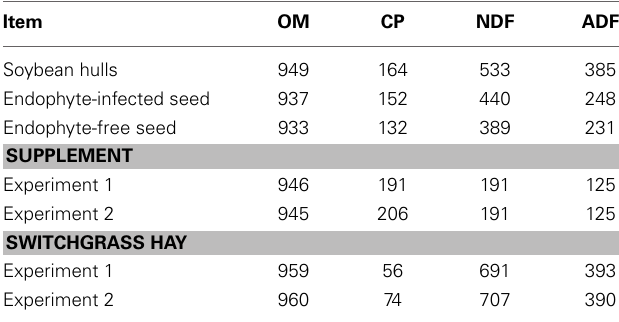
Table 1 | Organic matter (OM), crude protein (CP), neutral detergent fiber (NDF) and acid detergent fiber (ADF) concentrations, g/kg dry matter, in feedstuffs for the 2 experiments.